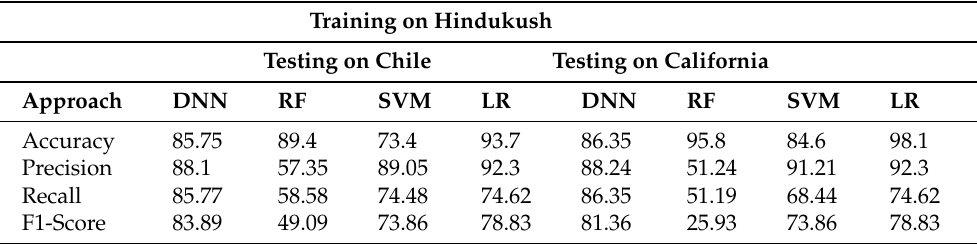
Table 7. Training on Hindukush, and testing on California and Chile.